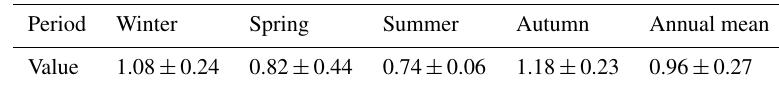
Figure 3. Seasonal climatological (a1–a4) PAR, (b1–b4) rainfall, (c1–c4) SST, (d1–d4) euphotic depth, (e1–e4) TSS, and (f1–f4) Chl a . The columns correspond to winter, spring, summer, and autumn. The unit of the numbers on the isobaths is meters. Table 1. Climatologically seasonal mean of the Chl a concentration in the